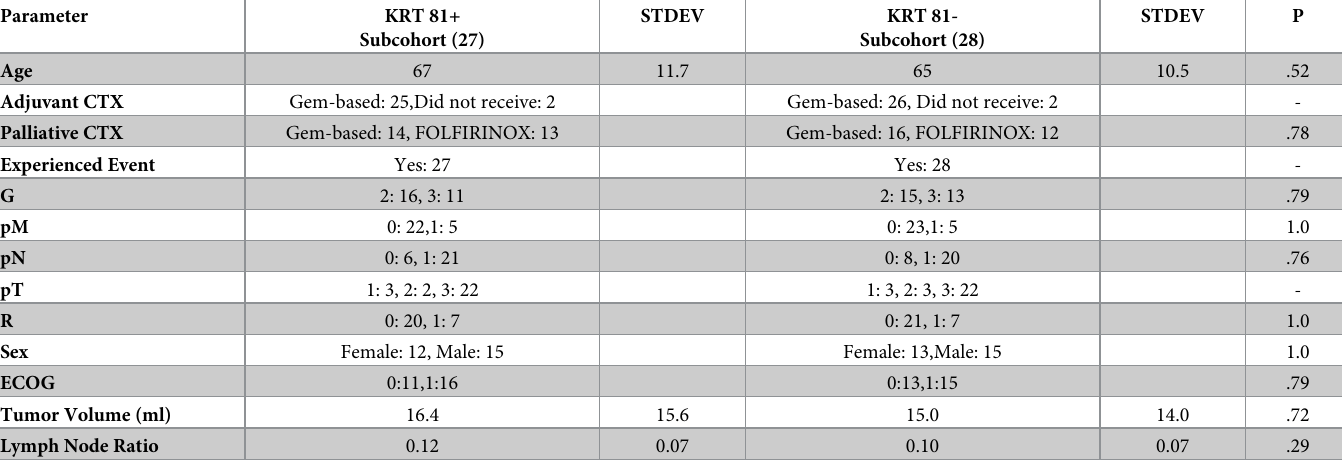
Table 2. Distribution of clinical parameters between the cohorts with KRT81+ and KRT81- tumor subtypes alongside crosstabulation results.